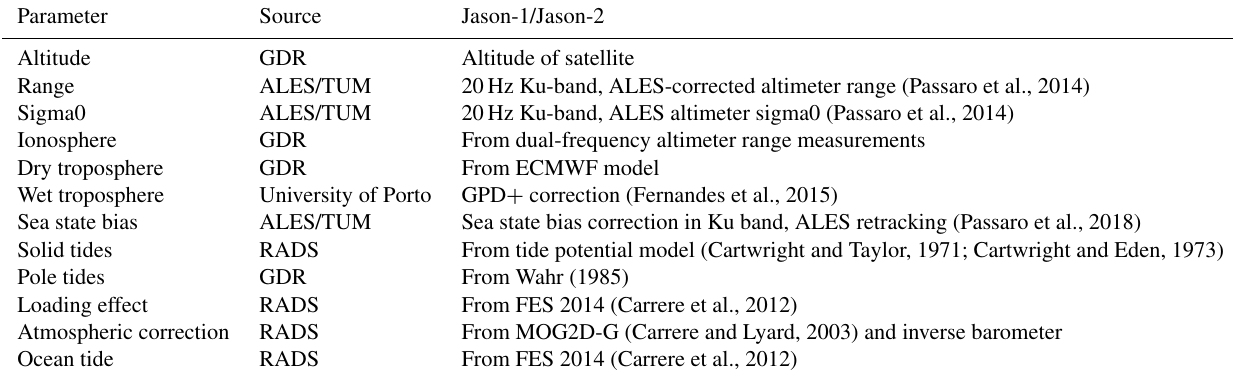
Table 1. List of altimetry parameters and geophysical corrections used in the computation of the coastal sea level products. Parameter